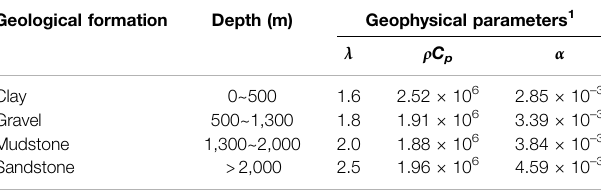
TABLE 2 | Detailed geophysical parameters of Weihe Basin, China Geological